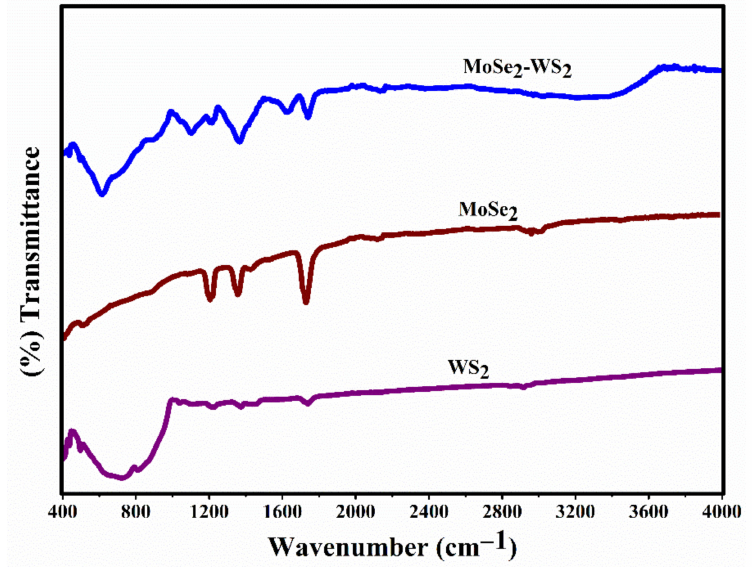
Figure 4. FTIR spectra of WS 2 , MoSe 2 , and MoSe 2 -WS 2 catalysts.